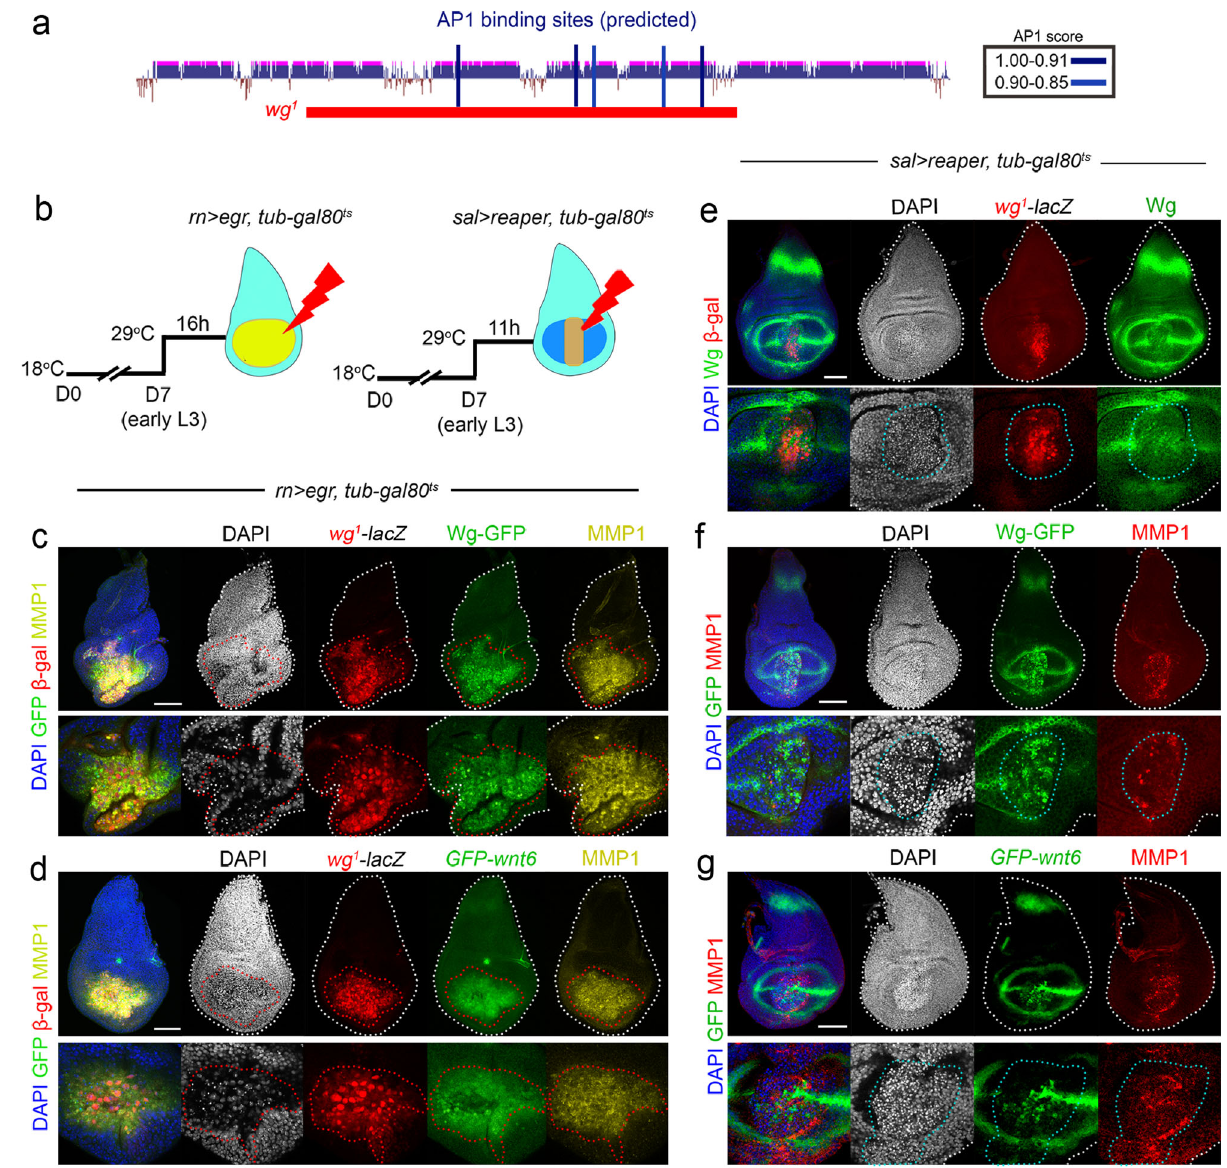
Fig. 5 | The wg 1 -enhancer is activated in apoptotic cells upon tissue injury. a Cartoon depicting the presence of bioinformatically predicted high-score AP1 binding sites (in blue) in the wg 1 - enhancer with the scores shown in the table. b Schematic representation of the Eiger- and Reaper-dependent wing ablation systems. Larvae were raised at 18°C for 7 days (D7) and switched to 29°C for16h ( c , d ) or 11h ( e – g ) to visualise gene expression. c – g Third instar wing discs of larvae bearing the indicated reporters, after Eiger ( c , d ) or Reaper ( e – g